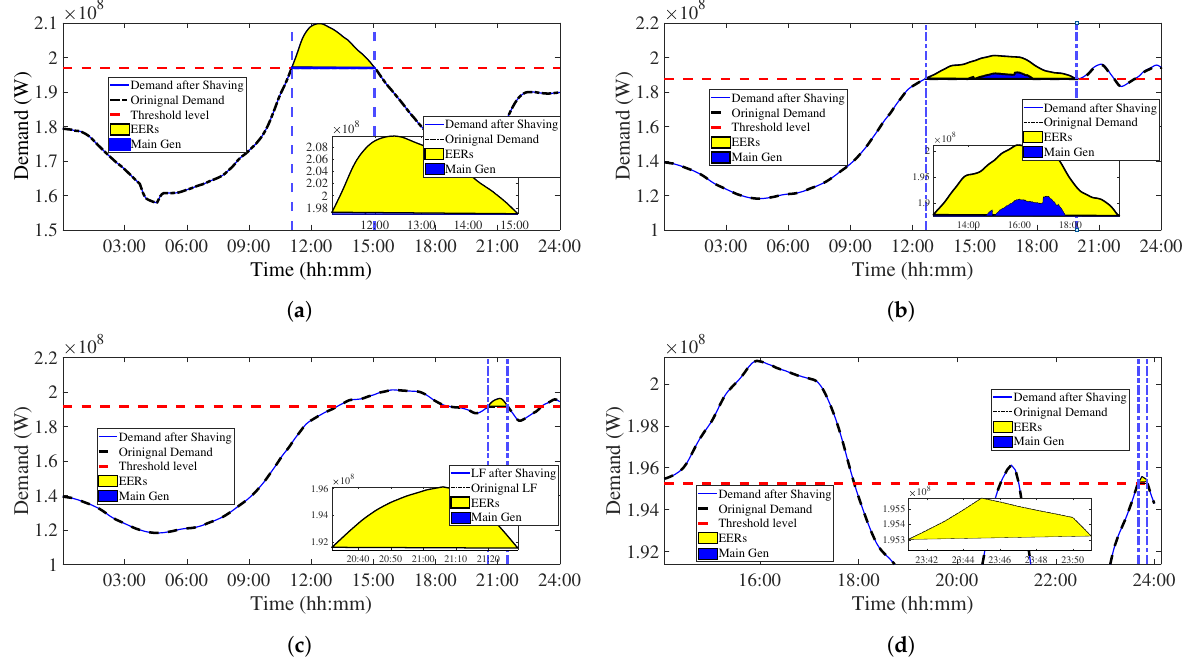
Figure 5. ( a ) First peak shave on 1 February; ( b ) first peak shave on 2 March; ( c ) second peak shave on 2 March; ( d ) third peak shave on 2